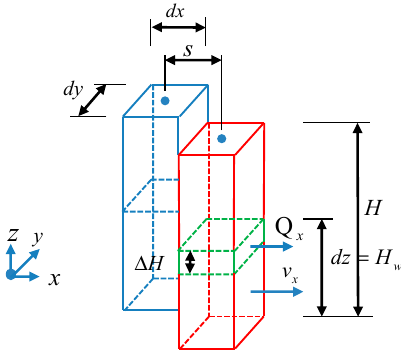
Figure 5. Sketch map of groundwater flow.